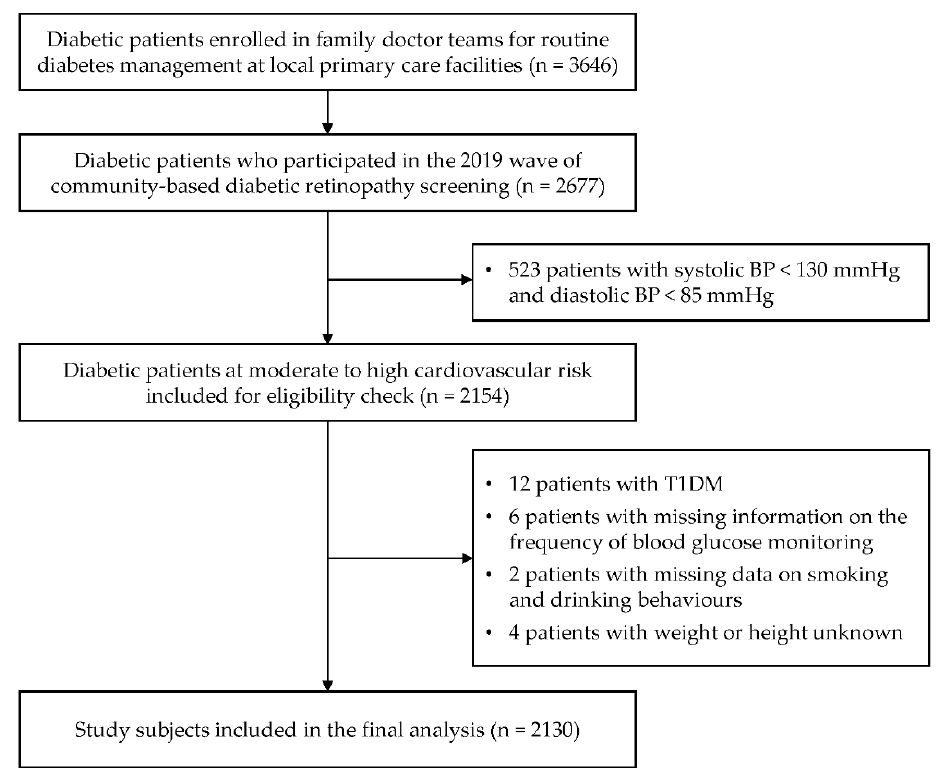
Figure 1. Flow chart of the study. T1DM, type 1 diabetes mellitus; T2DM, type 2 diabetes mellitus; BP, blood pressure.